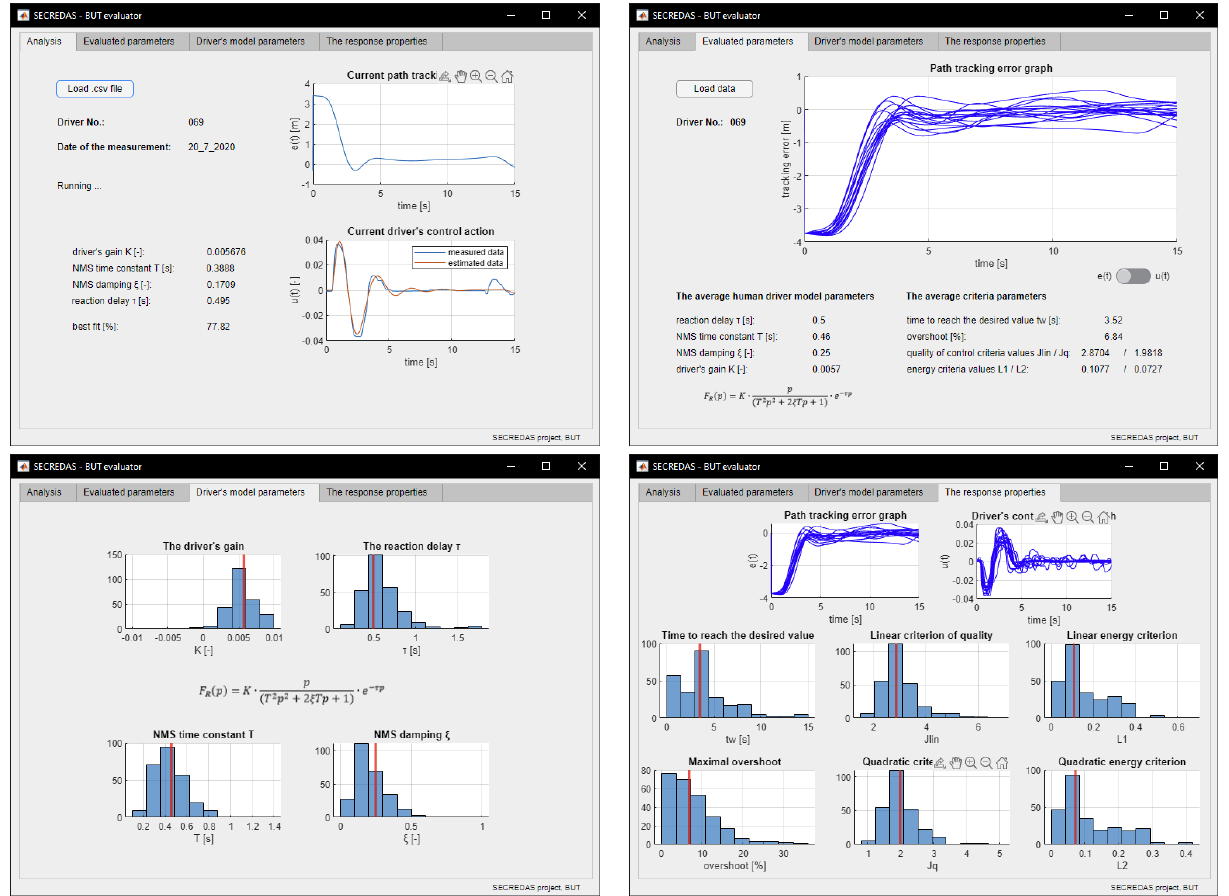
Figure 10. The VDS data processing